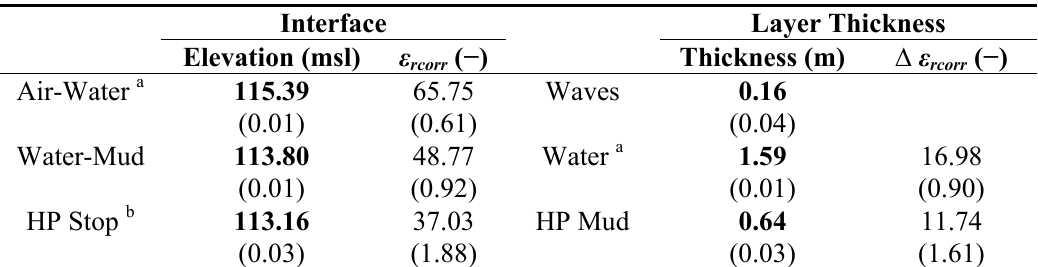
Table 1. Mean interface elevation (msl) and mean layer thickness (m) indicated by changes in ε that delineate air, water, and mud in point rcorr